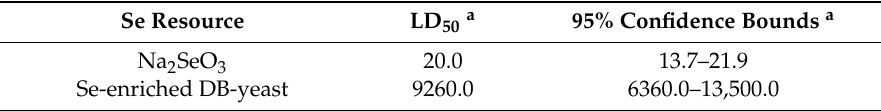
Table 3. Evaluation of Na 2 SeO 3 and Se-enriched DB-yeast toxicity against mouse by using Horn method. LD 50 —half lethal